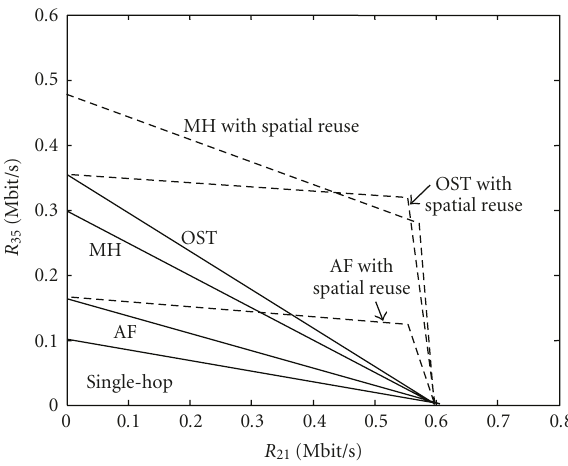
Figure 4: Capacity regions slices in the plane R 21 versus R 35 for dif- ferent transmission protocols.